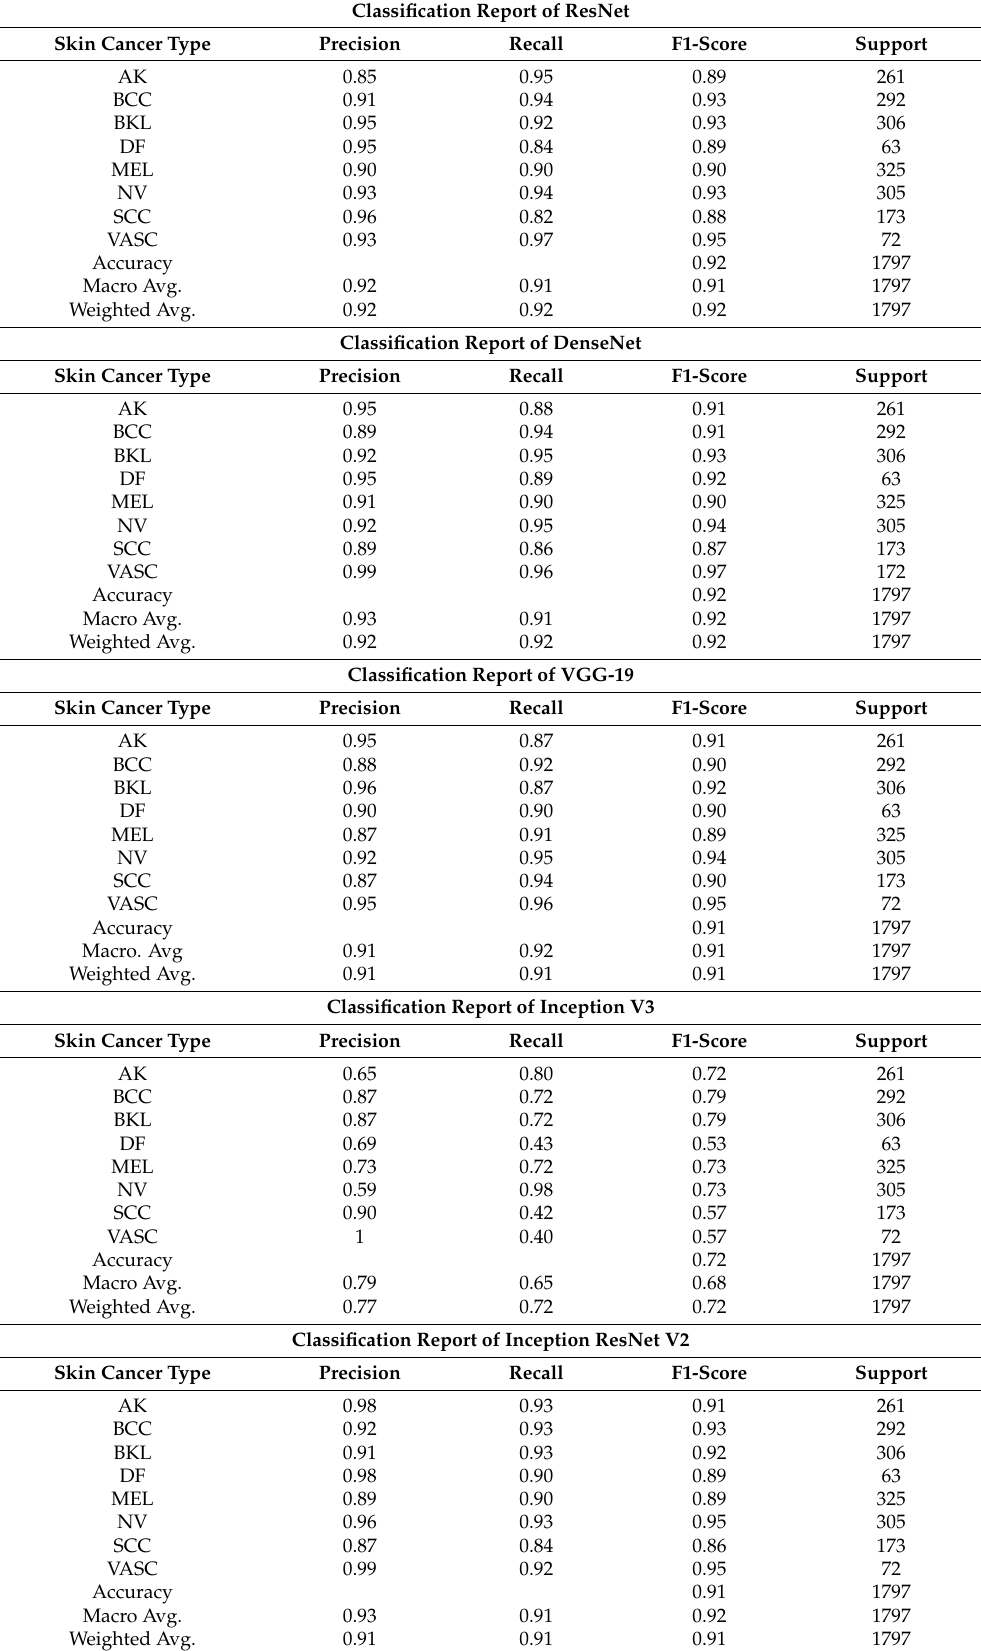
Table 2. Performance comparison of individual learners with the ensemble